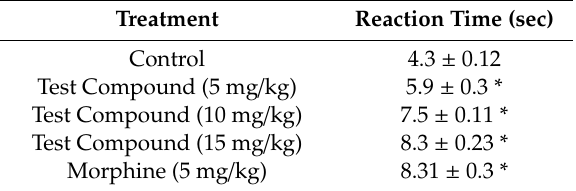
Table 3. E ff ect of quercetin-3-methoxy-4 (cid:48) -glucosyl-7-glucoside on tail flick response in